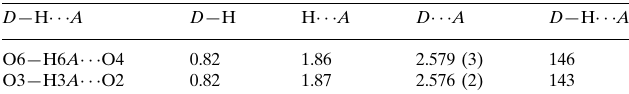
Hydrogen-bond geometry (A˚ , (cid:1) ). D —H (cid:4)(cid:4)(cid:4)